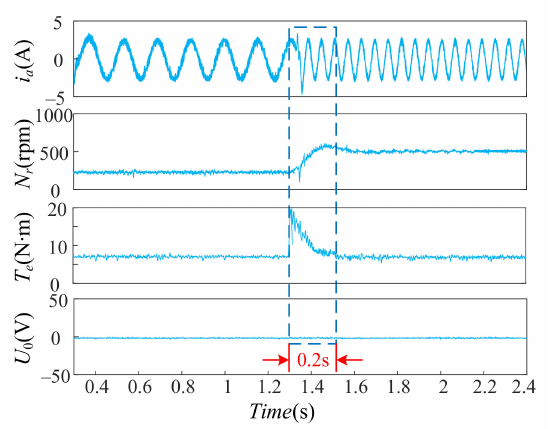
Figure 12. Dynamic experimental results during the speed step-change.